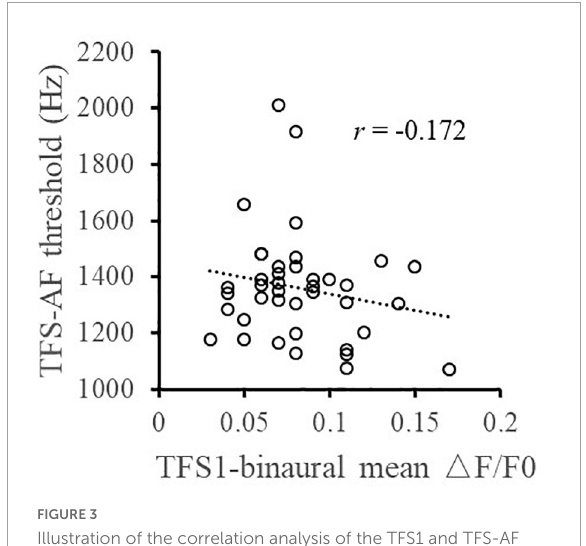
FIGURE3 Illustration of the correlation analysis of the TFS1 and TFS-AF test.